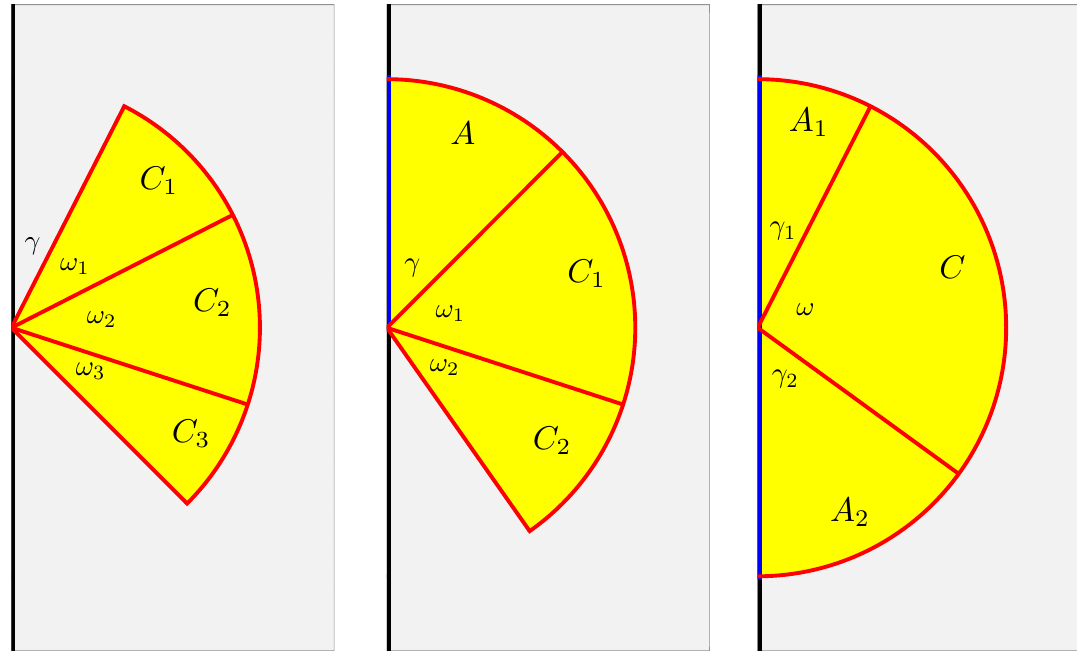
Figure 2 . Con(cid:12)gurations of adjacent domains containing corners (yellow regions) in the half plane x > 0 (grey region) which have been used in section 2 to constrain the corner functions through the strong